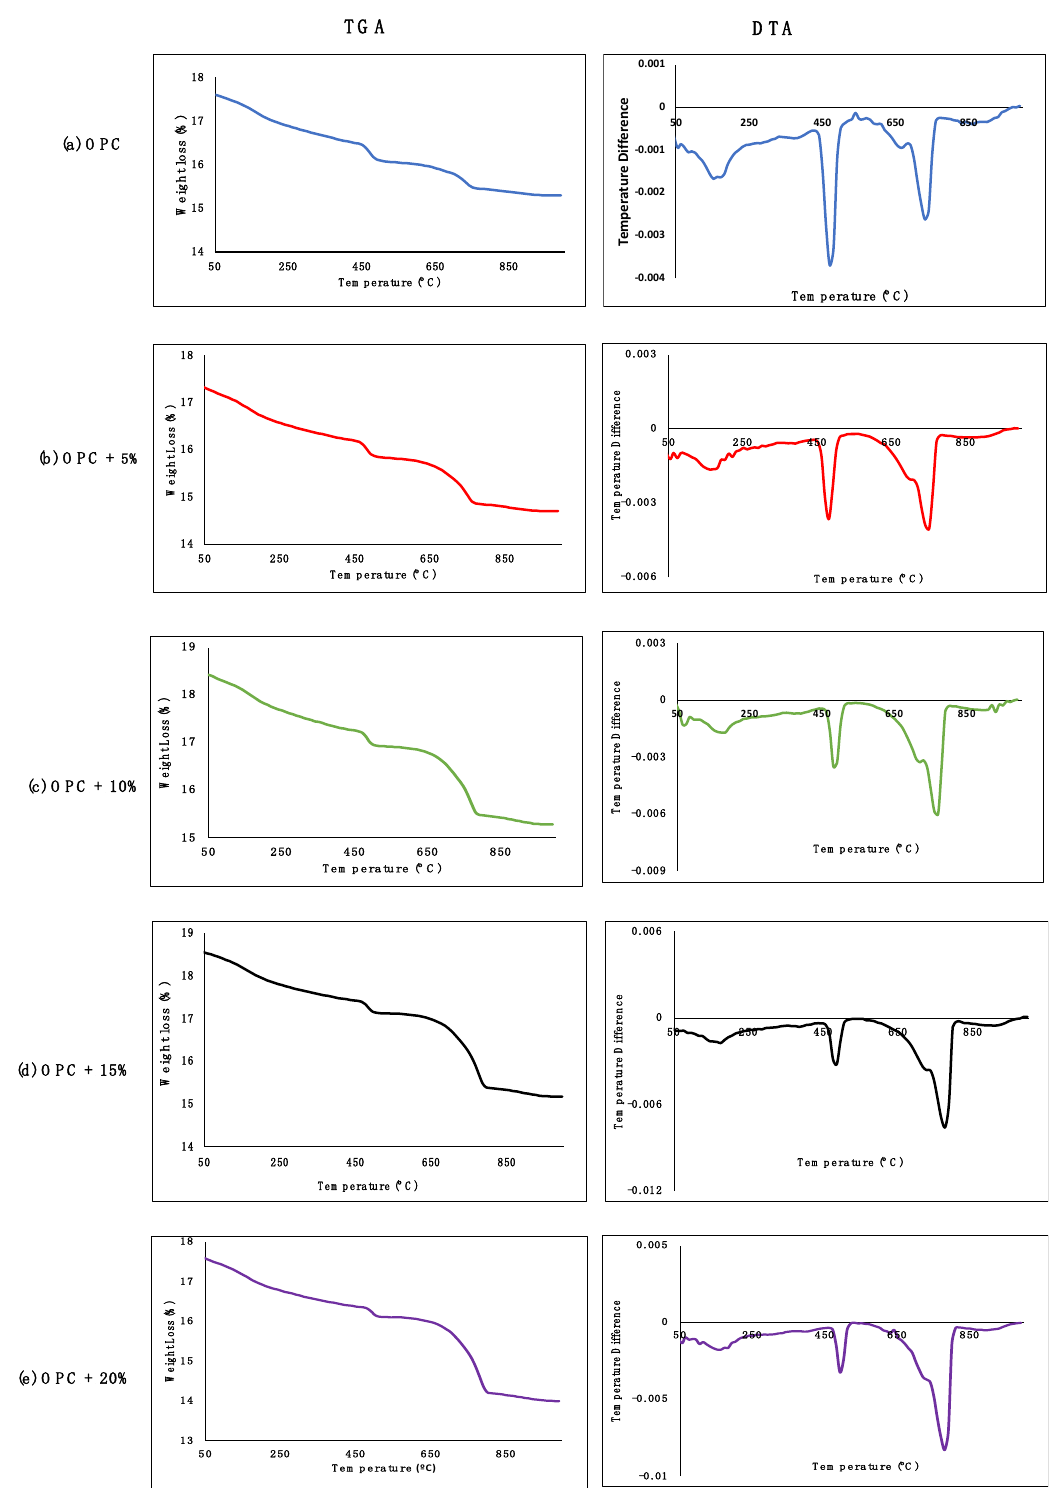
Figure 7. Thermogravimetric analysis (TGA) and differential thermal analysis (DTA) analysis of OPC–CMW blended cement pastes containing 5, 10, 15, and 20 wt. % calcined CMW nanoparticles.